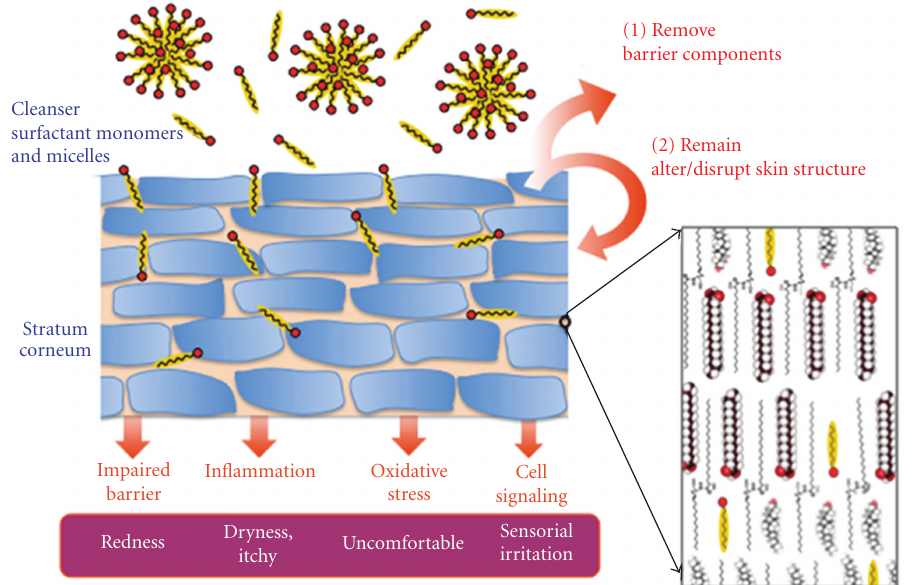
Figure 1: Depiction of how surfactants within a cleanser can remove SC material and also remain in the SC. The lengths scales of the cartoon at the left are inaccurate; corneocytes have diameters ∼ 20 µ m, while the micelles sizes are ∼ 5nm. At the right, a molecular-level illustration of ordered SC lipids (ceramides, cholesterol, and fatty acids) and surfactants from a cleanser inserting into these ordered SC lipids.